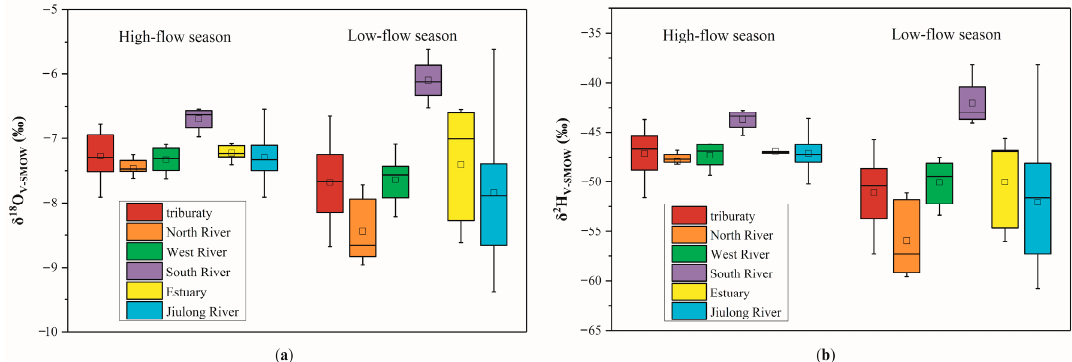
Figure 4. Box diagrams for δ 18 O ( a ) and δ 2 H ( b ) in the high-flow season and low-flow season of the main stream and its tributaries in the Jiulong